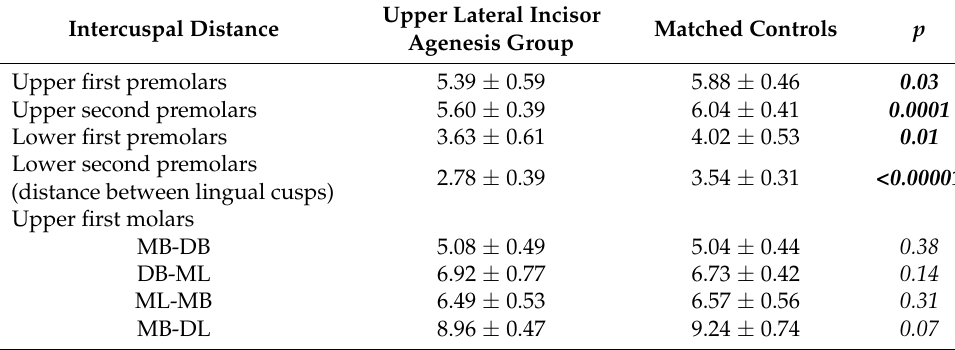
Table 5. Mean intercuspal distances in premolars and upper first molar.